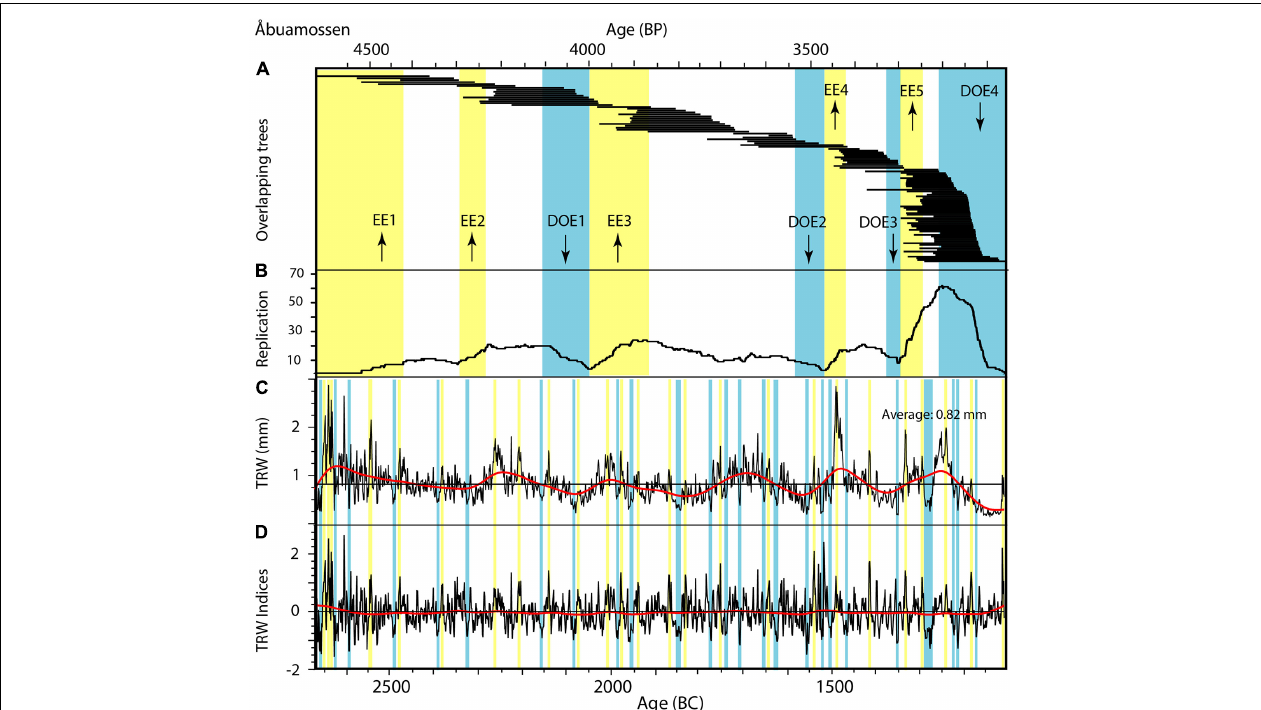
FIGURE 4 | Example showing a tree-replication record and a tree-ring width chronology. The example is based on the 1561-year tree-ring chronology from Åbuamossen (Edvardsson, 2013). (A) The horizontal black lines represent individual trees sorted by ending years. Five tree-establishment (EE1–5) and four dying-off (DOE1–4) events are shown in yellow and blue, respectively. (B) Sample replication, number of overlapping samples. (C) Averaged tree-ring width (TRW) chronology (mm). (D) Averaged and standardized TRW chronology (dimensionless indices). The smooth red curves are 20-year low-pass filter splines highlighting the low-frequency patterns of variability. The blue fields are periods of 3 years in a row or longer with depressed growth (TRW indices < 1 SD), whereas the yellow fields show corresponding periods with strong growth (TRW indices > 1 SD). The replication record show population changes, often on a decadal resolution whereas the tree-ring width data show the year-by-year growth variability of the